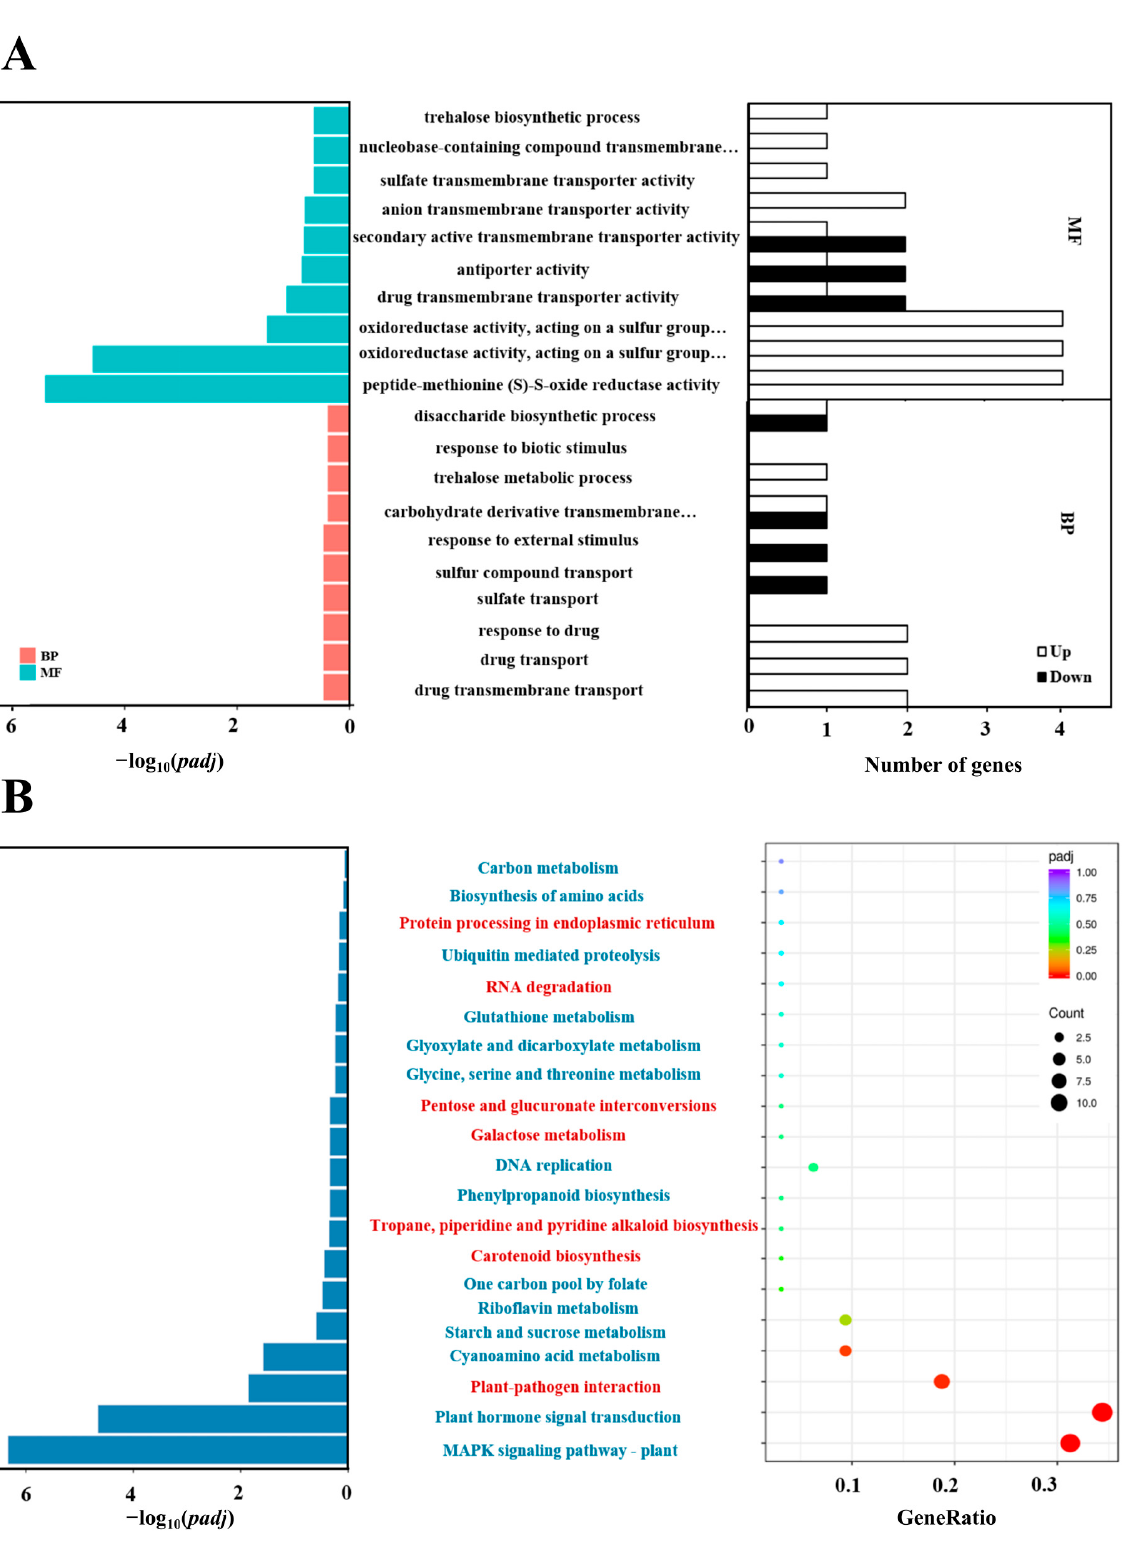
Figure 7. ( A ) GO enrichment analysis of DEGs. Bar graphs indicate the twenty most enriched GO terms (ranked by p ‐ adjusted values) and the numbers of up ‐ and down ‐ regulated genes correspond ‐ ing to the top ten GO terms in each of the two categories (BP: biology process, MF: molecular func ‐ tion). ( B ) Histogram presentation of the Kyoto Encyclopedia of Genes and Genomes (KEGG) classi ‐ fication of DEGs. Bar graphs indicate the 20 most significant enriched KEGG pathways (ranked by p ‐ adjusted values). KEGG dot plot, the 21 biological processes with the largest gene ratios are plot ‐ ted in order of gene ratio. The size of the dots indicated by ‘Count’ represents the number of genes in the significant DEGs list associated with the GO term, and the color of the dots represents the p ‐ adjusted values. Gene ratio represents the ratio of the number of differentially expressed genes